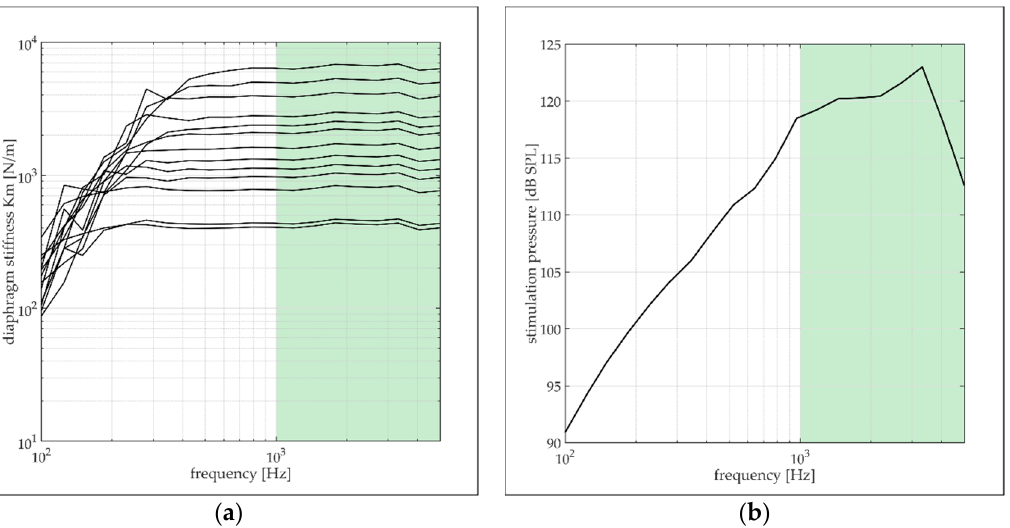
Figure 8. ( a ) Diaphragm stiffness as a function of the stimulation frequency between 100 Hz and 5 kHz. The stiffness data were determined from vibration amplitude measurements (LDV) on the diaphragms driven with acoustic sound; ( b ) sound pressure levels driving the diaphragms between 100 Hz and 5 kHz. The green area in both figures indicates the frequency range considered for averaging the stiffness data over the frequency.